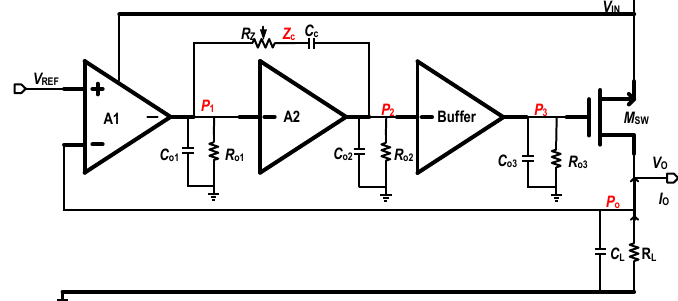
Figure 4. The pole–zero distribution of the proposed regulation circuit.